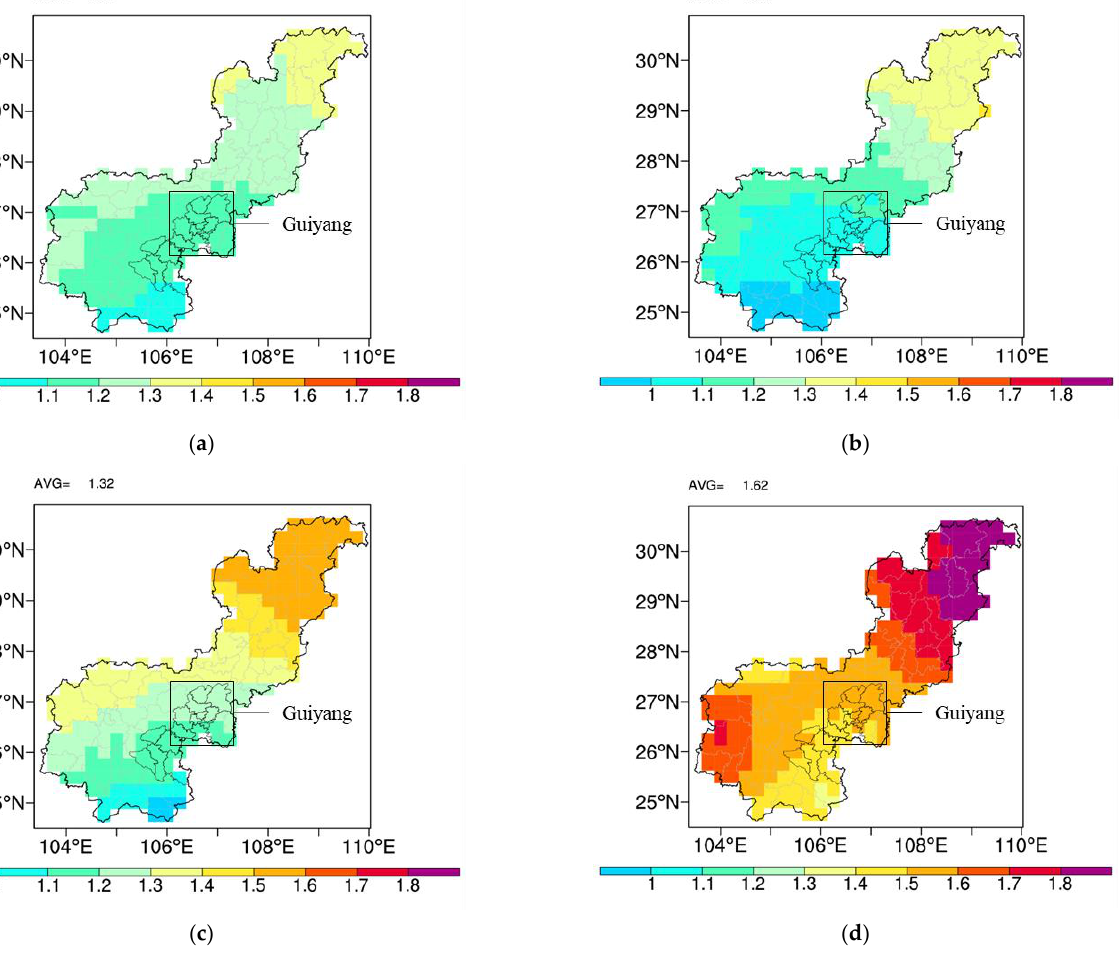
Figure 6. Guiyang – Anshun basin area annual average temperature in 21st century (RCP4.5, 2021 – Figure 6. Guiyang–Anshun basin area annual average temperature in 21st century (RCP4.5, 2021–2055 2055 compared to 1986 – 2005, Celsius Degree). ( a ) 2021 – 2030; ( b ) 2026 – 2035; ( c ) 2031 – 2040; ( d ) 2046 – 2055.